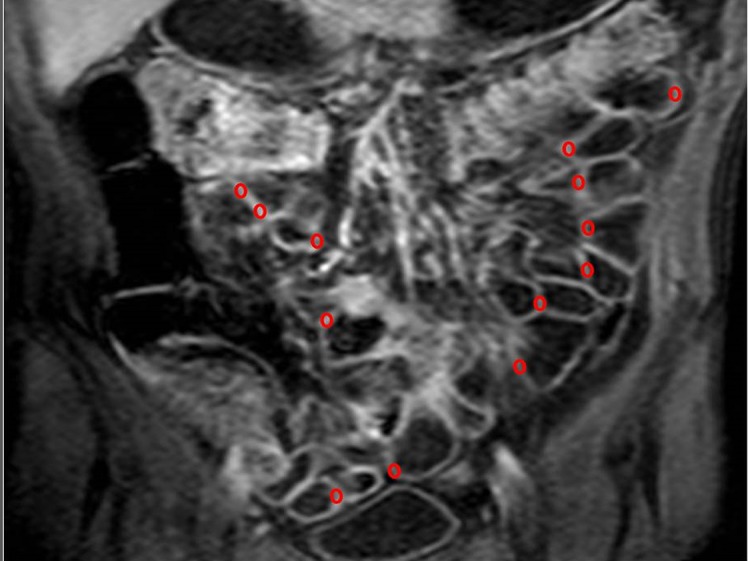
Assessment of small bowel wall perfusion.To calculate MRI perfusion parameters, AUC60, AUC90 and Ktrans, elliptic ROIs were positioned in different segments of the small bowel wall, particularly on proximal and distal jejunum and proximal, middle and distal ileum, as showed in this figure.